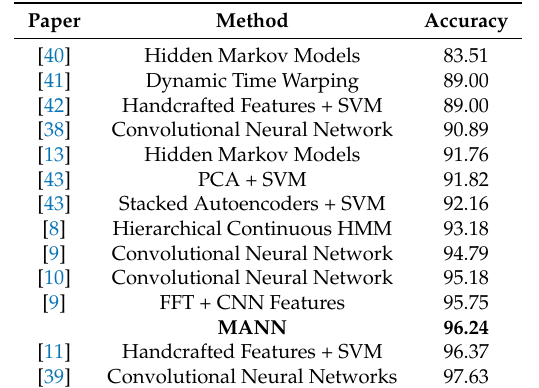
Table 2. Comparison between the MANN results and the literature results on the SBHAR dataset